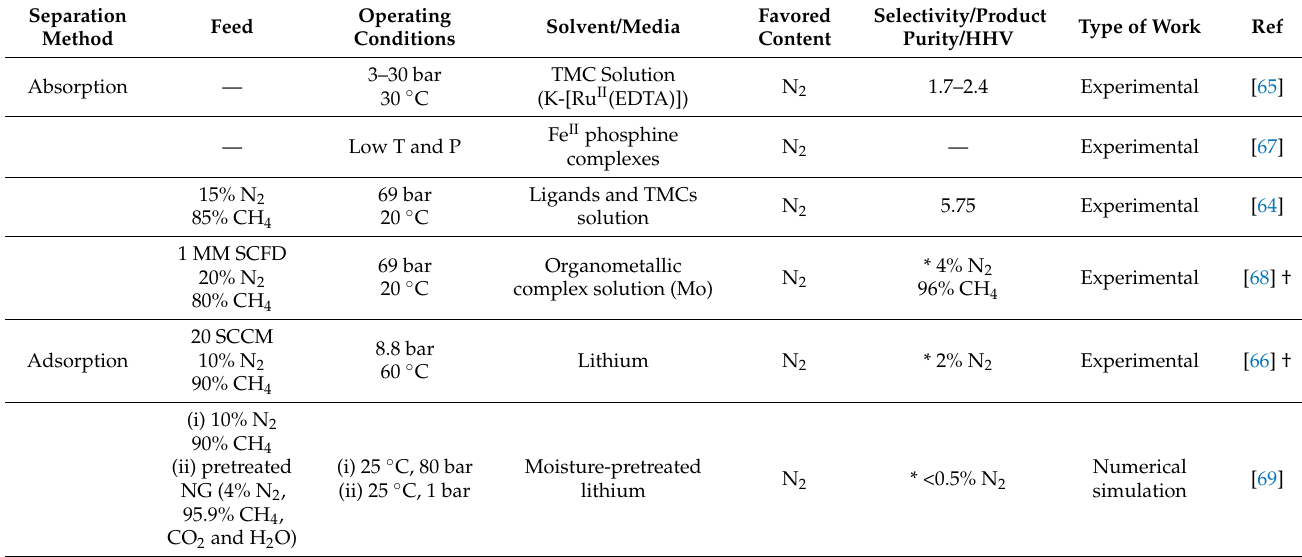
Table 3. Summary of N 2 removal from NG through chemical processes.